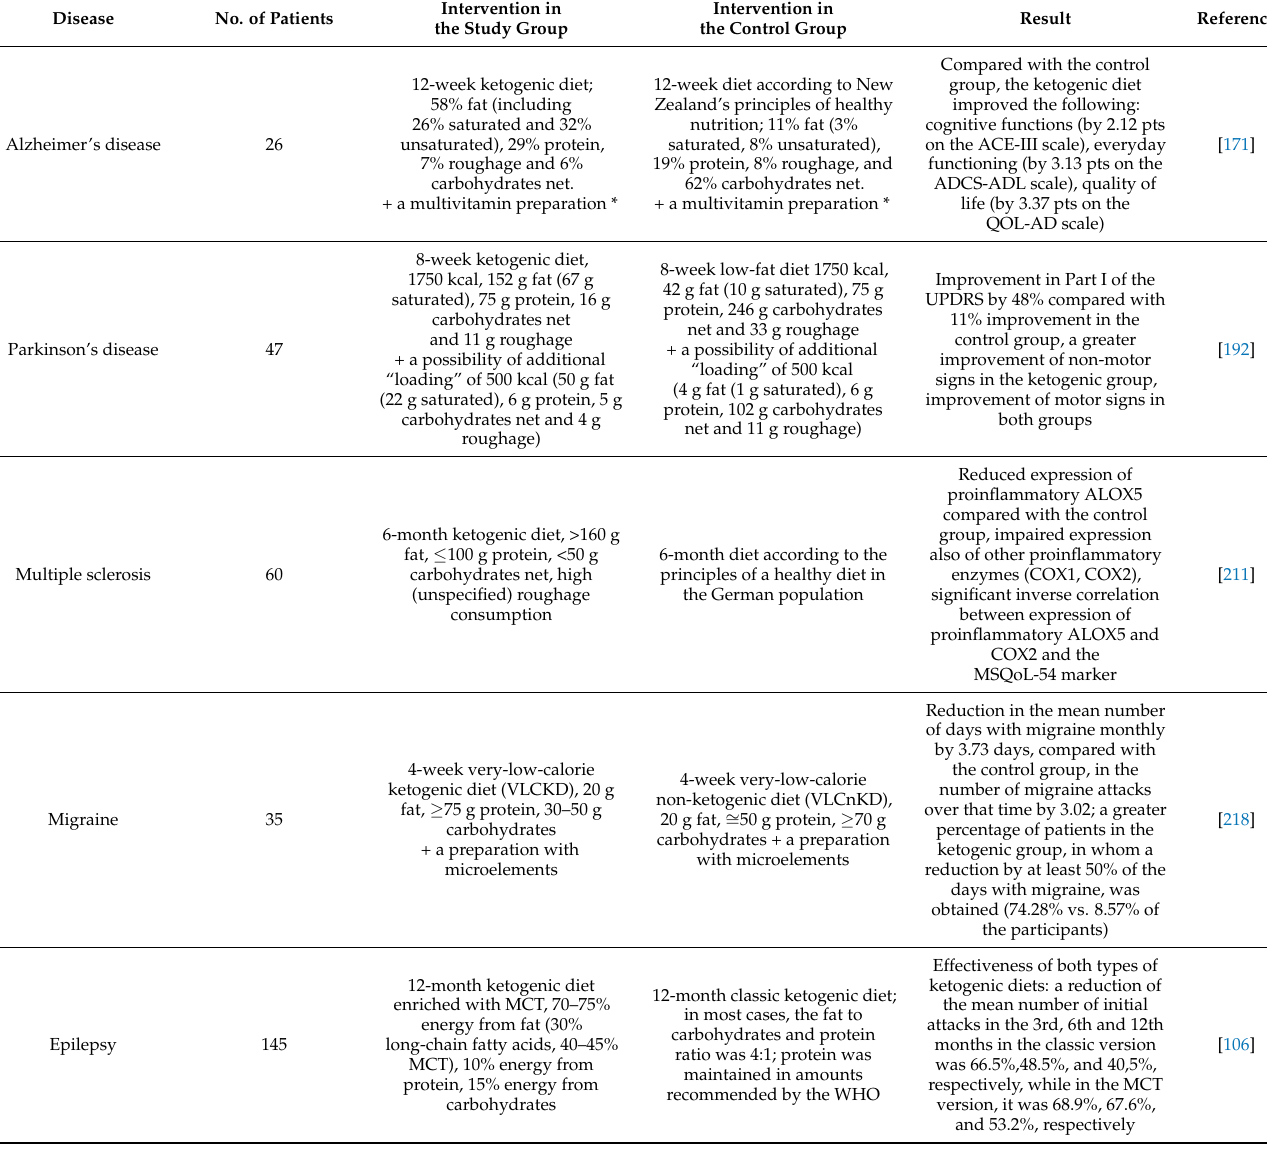
Table 1. Review of selected randomised controlled studies concerning the effect of the ketogenic diet on the discussed neurological